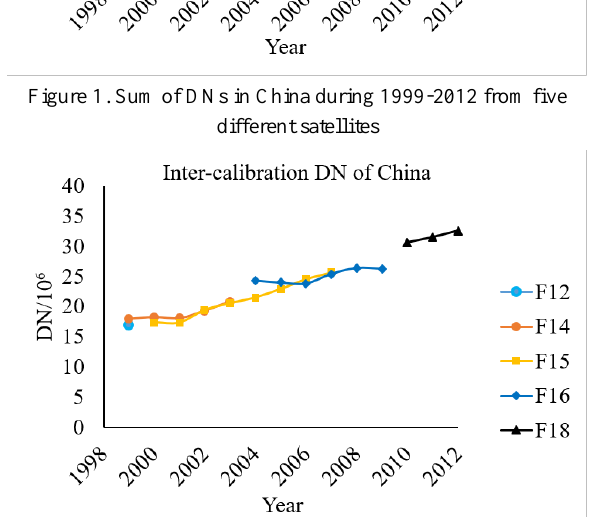
Figure 2. inter-calibration sum of DNs in China during 1999- 2012 from five different